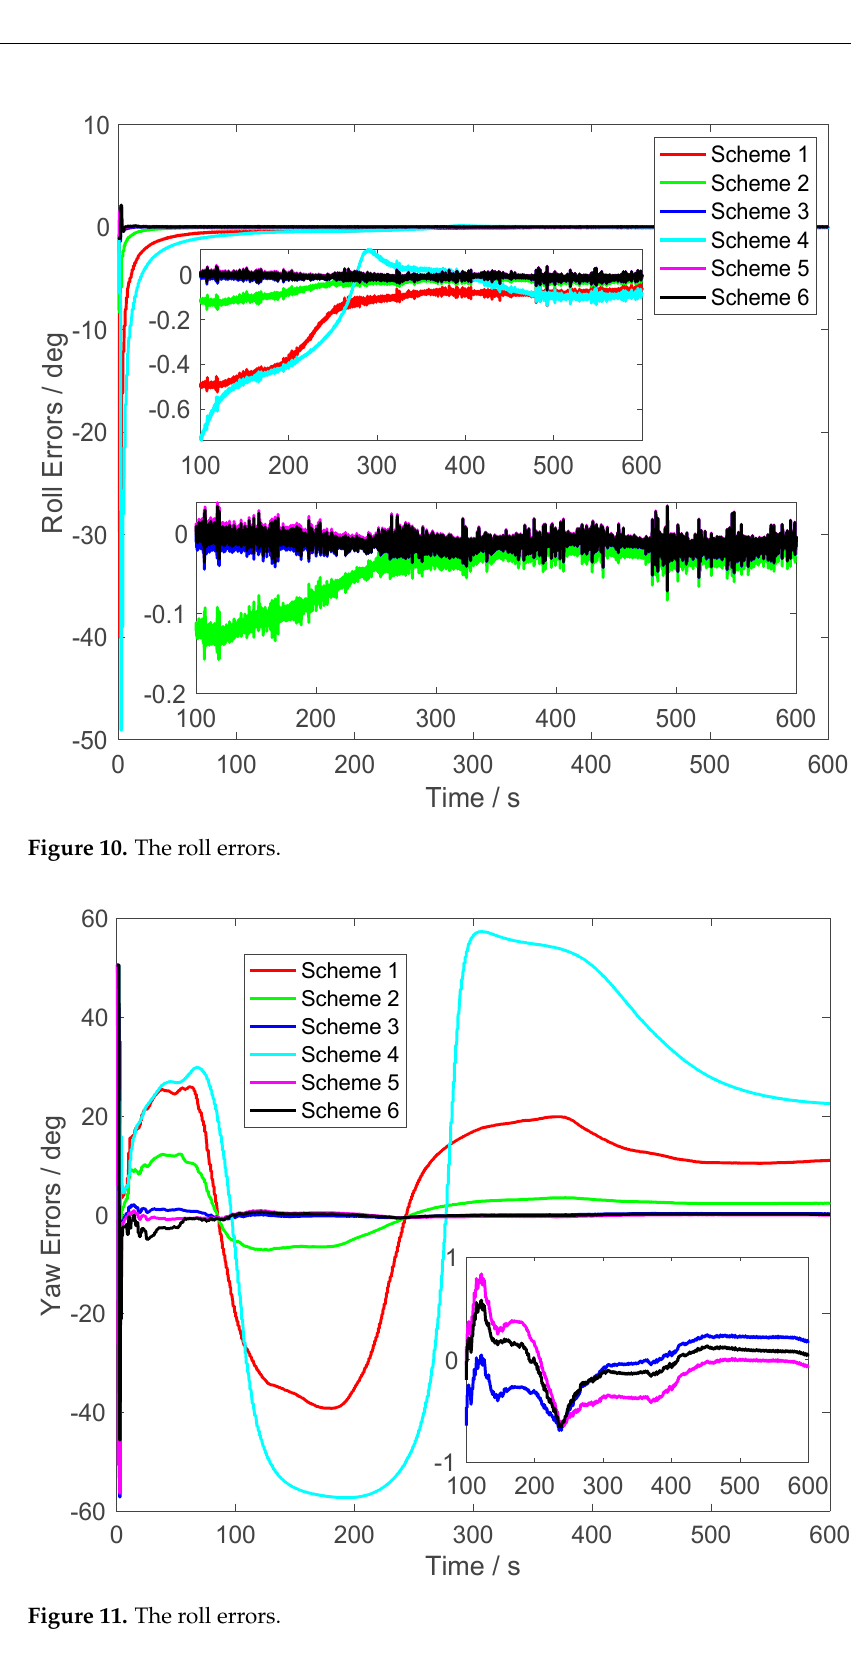
Figure 11. The roll errors.